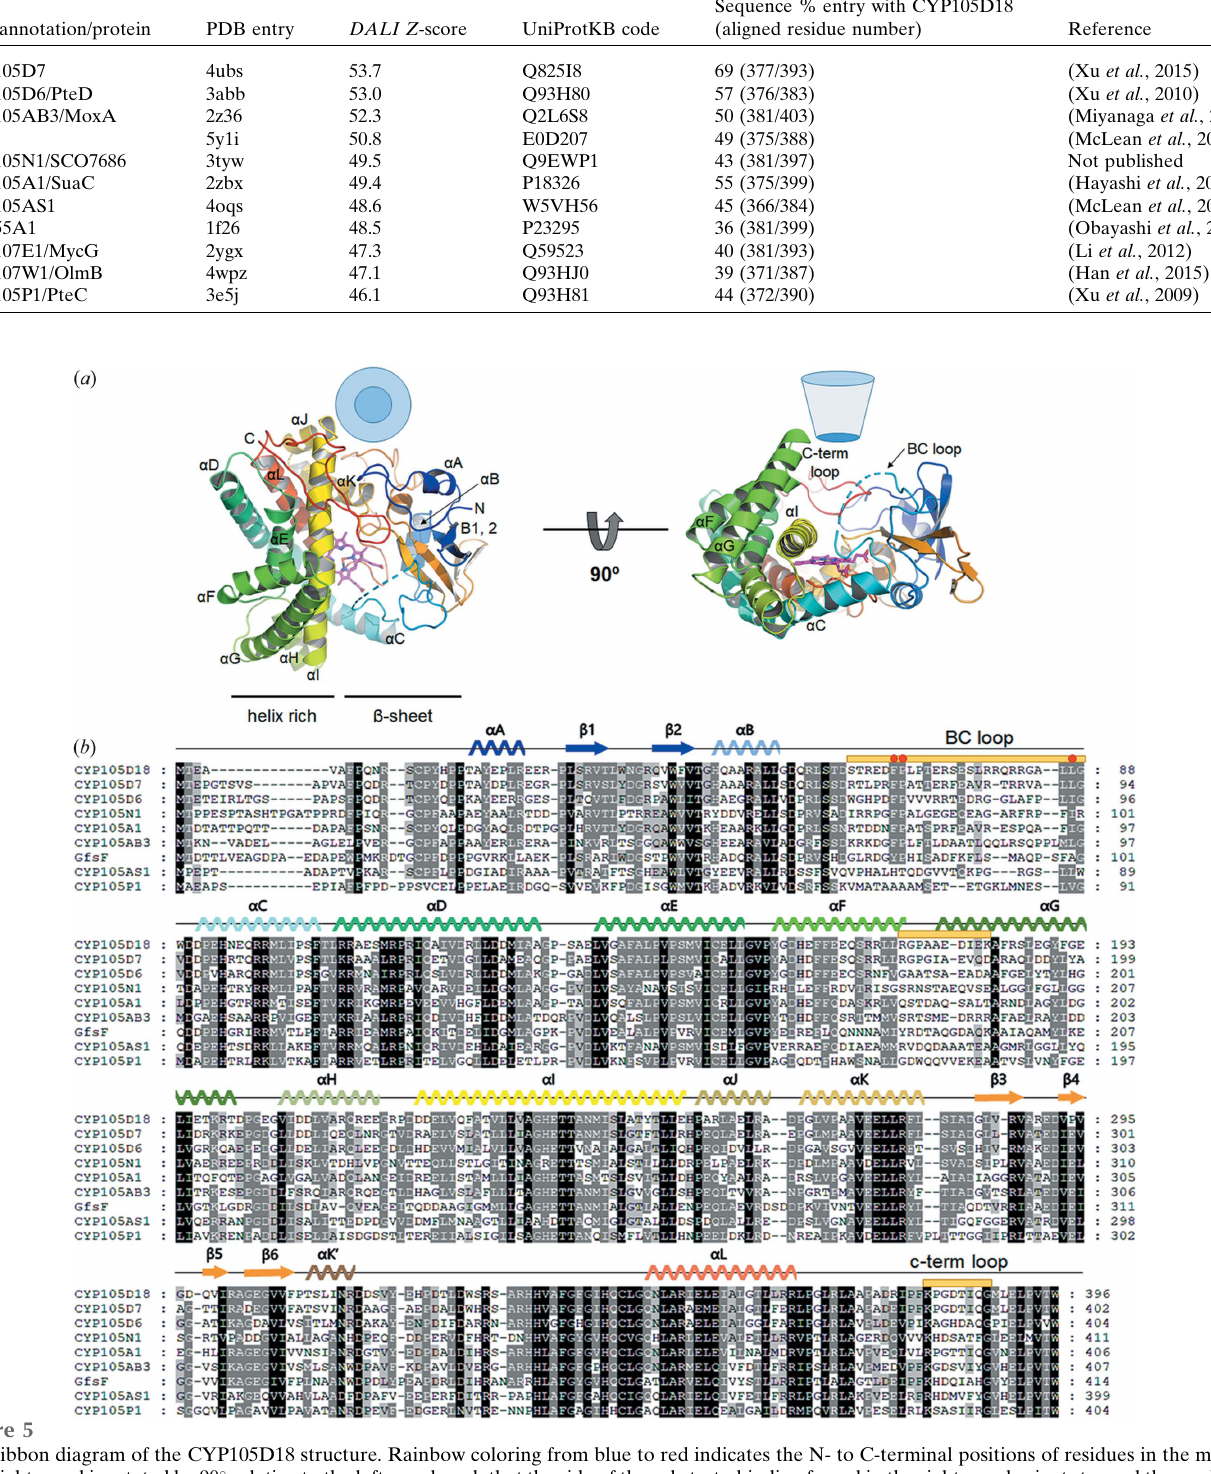
Table 2 Structural homolog search results for CYP105D18 from a DALI search ( DALI-Lite server). CYP annotation/protein